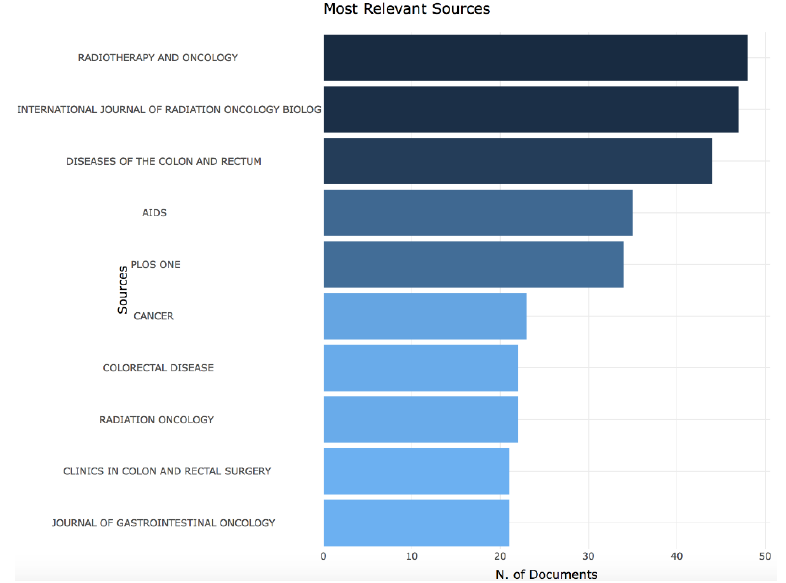
Figure 5. Most relevant